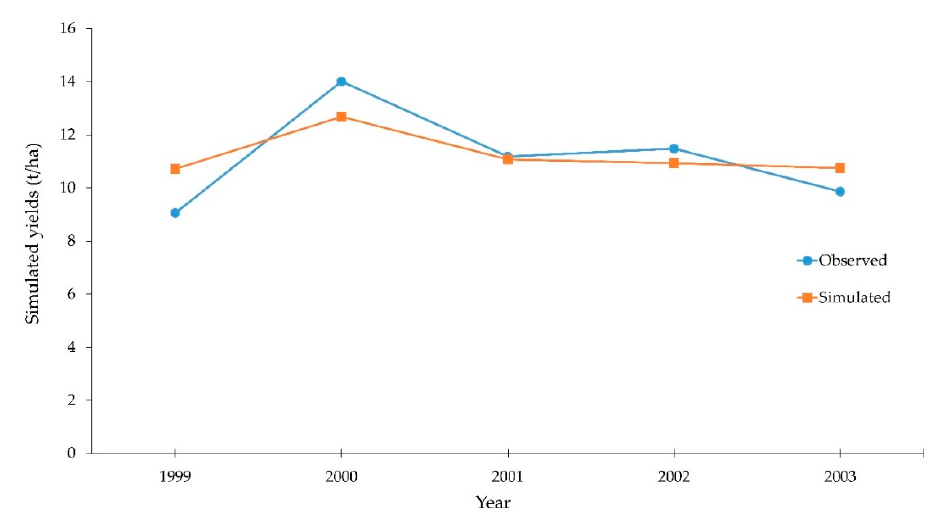
Figure 6. Comparison of observed yields in tonnes per hectare (t ha − 1 ) and simulated yields in the validation simulation with the calibrated model.